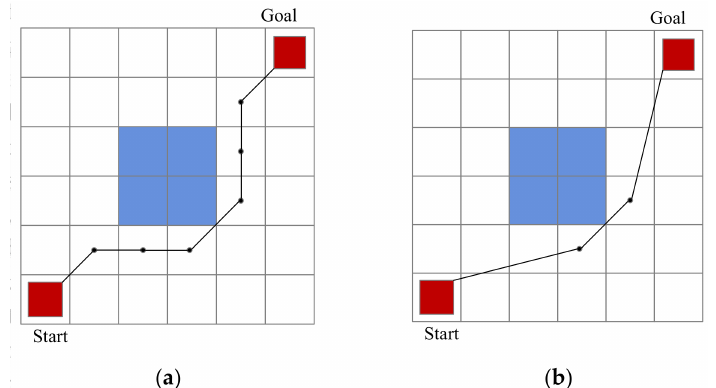
Figure 2. Shortest path with different direction limitations ( a ) under direction limitation; ( b ) without direction